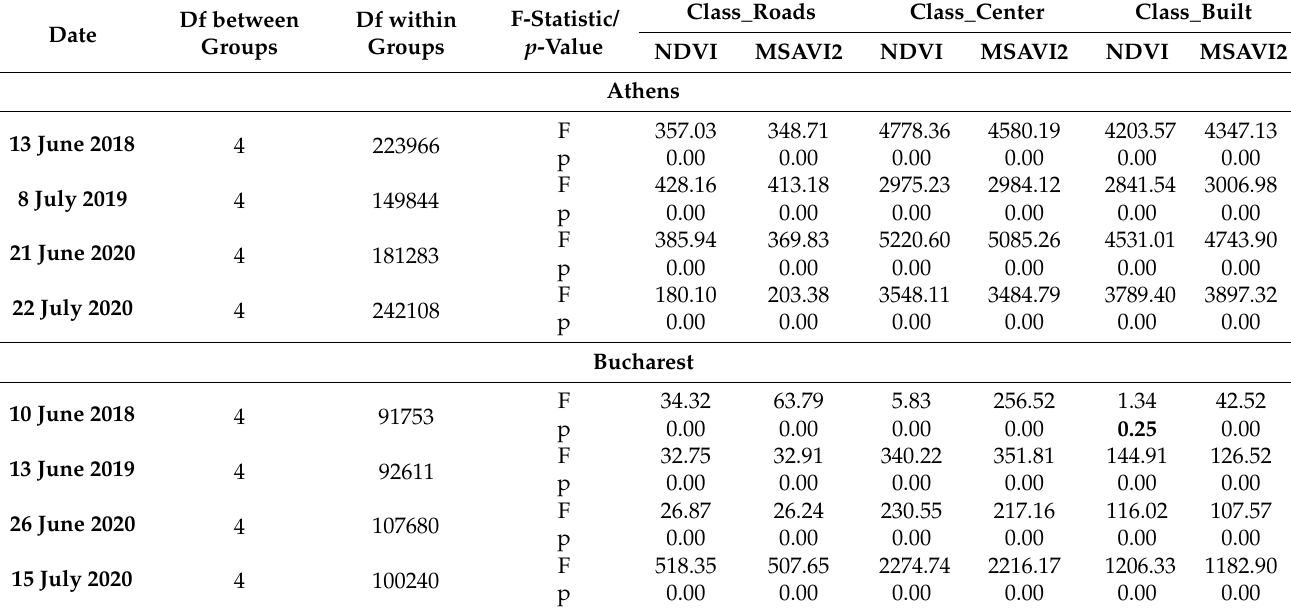
Table 4. ANOVA test results for mean values of NDVI and MSAVI2 for Bucharest and